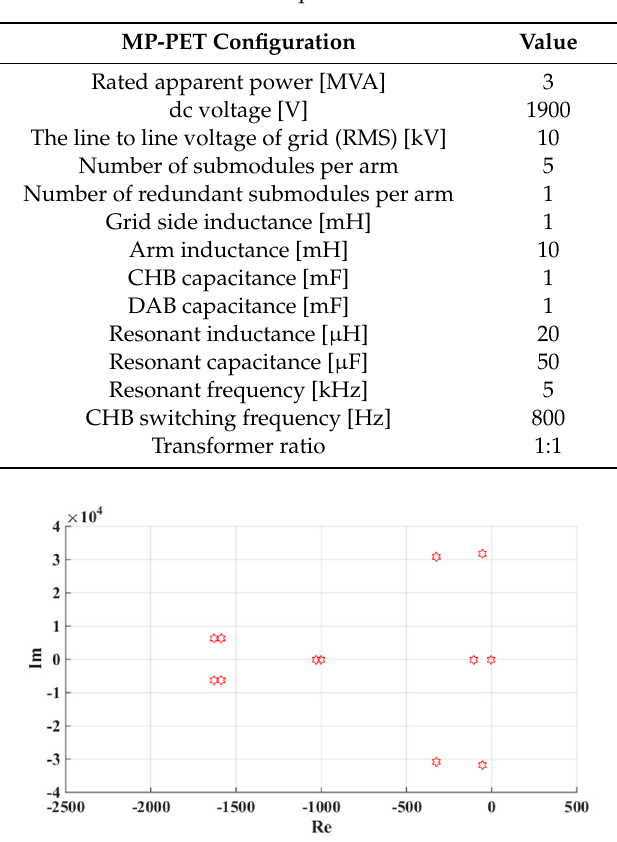
Table 2. Main circuit parameters of MP-PET.